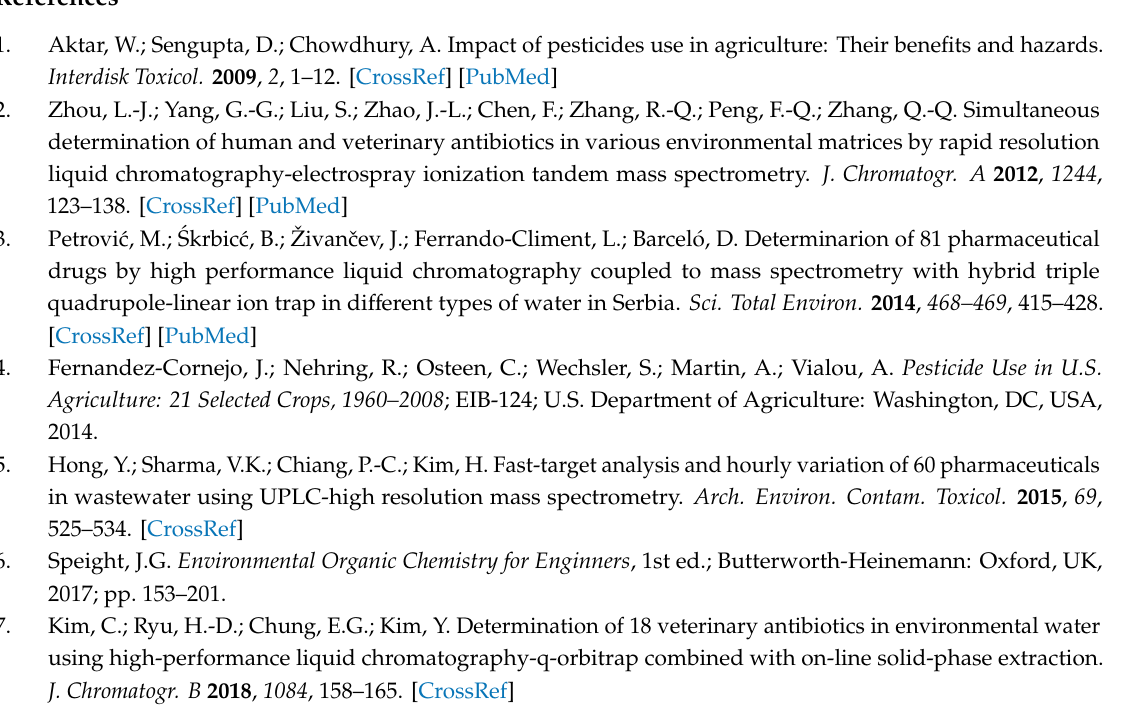
Figure S1: HPLC traces of standard solutions (750 ng · L − 1 ) for the target chemicals, Figure S2: HPLC traces of standard solutions (250 ng · L − 1 ) of the ISTDs, Figure S3. Calibration curve for the selected target